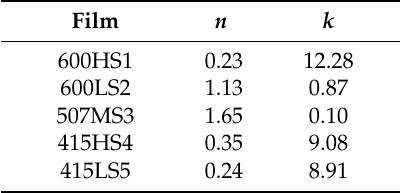
Table 2. Values of the fitting parameters ( k and n ) for the power-law response model defined in Equation (2). These values correspond to the experimental data presented in Figure